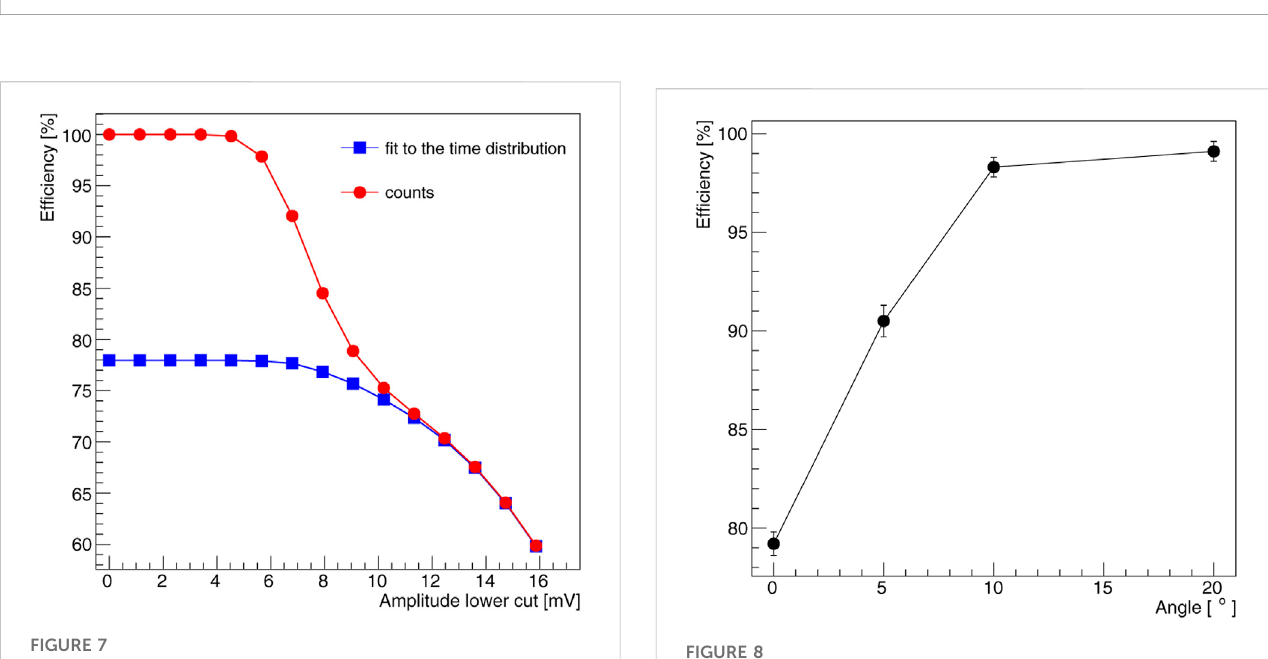
FIGURE 8 Triple strip ef fi ciency as a function of the tilt angle with respect to normal sensor incidence. The DUT is rotated around the pixel-strip